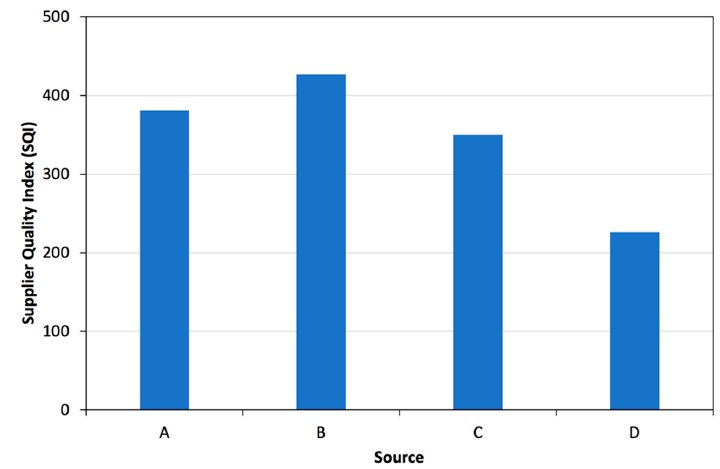
Figure 11. Supplier Quality Index of different source.